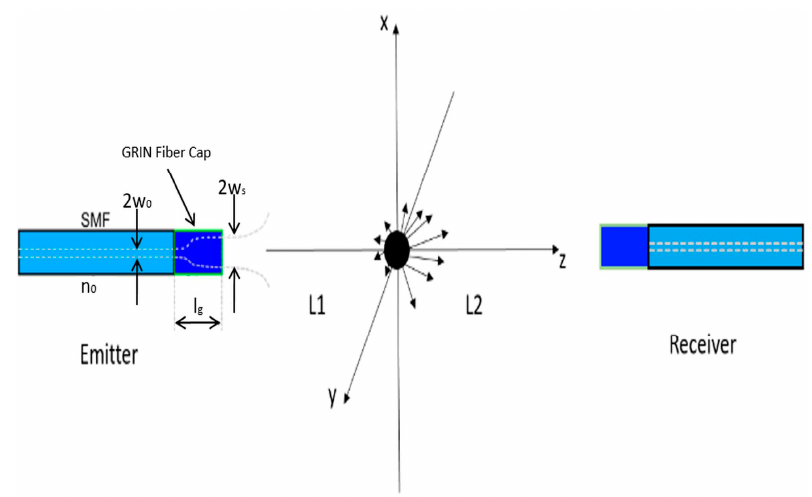
Figure 1. The light from the emitting fiber is a single mode beam, and the receiving fiber is also single mode. When the particle passes through the beam the resulting signal loss in mode coupling is larger than just the geometric occlusion of the size of the particle blocking the